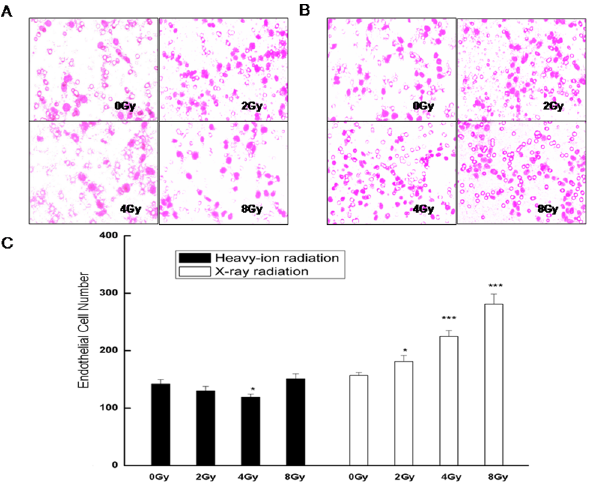
Fig 2. Effect of radiation on endothelial cell migration as assessed by the Boyden chamber migration assay. Representative images are shown of migrating HMEC-1 cells exposed to conditioned medium from cultures of A. unirradiated or heavy ion-irradiated, or B. unirradiated or X ray-irradiated glioma cells. C. Quantification of the number of migratory endothelial cells is expressed as means ± standard error of the mean from three independent experiments, in which treatments were performed in triplicate. * P < 0.05, *** P < 0.001 vs. controls (0